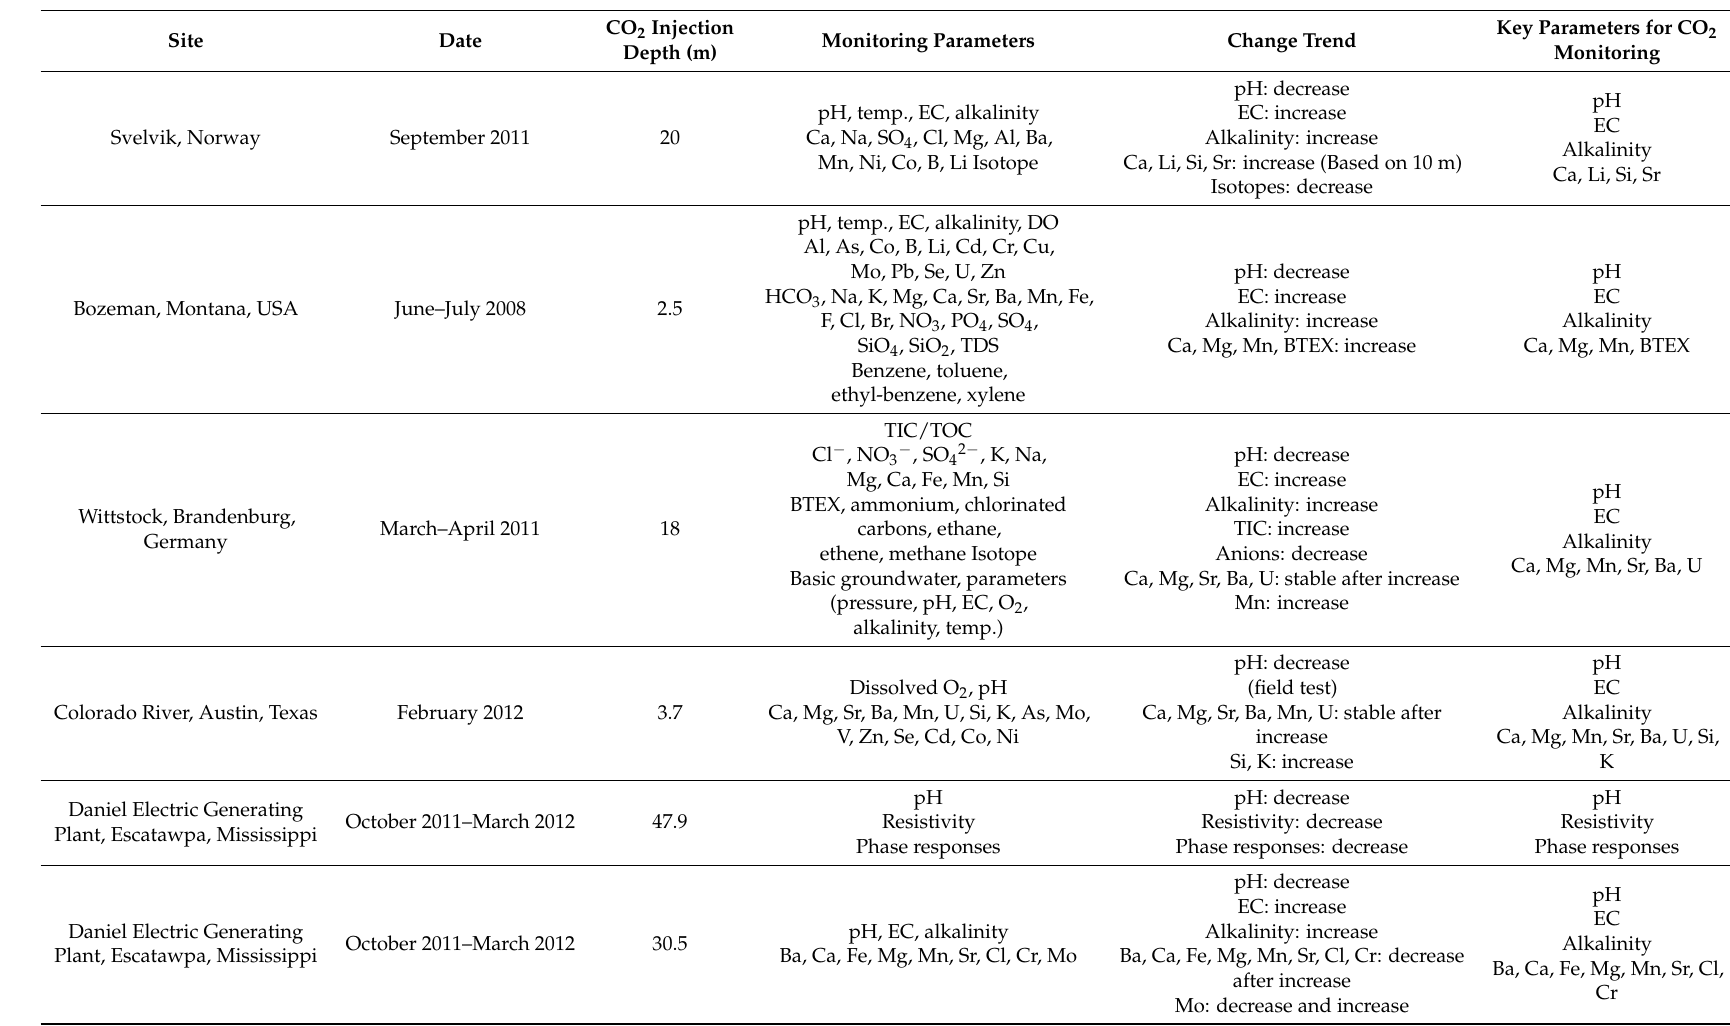
Table 1. Key parameters for CO 2 monitoring